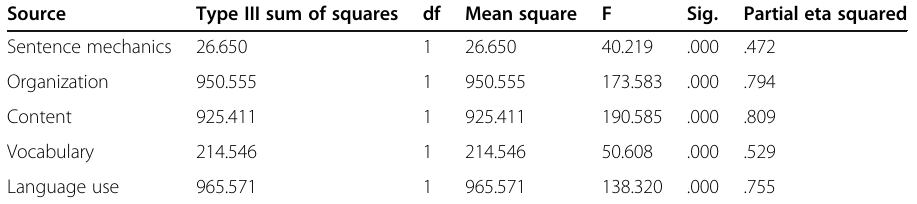
Table 7 Multiple regression analysis